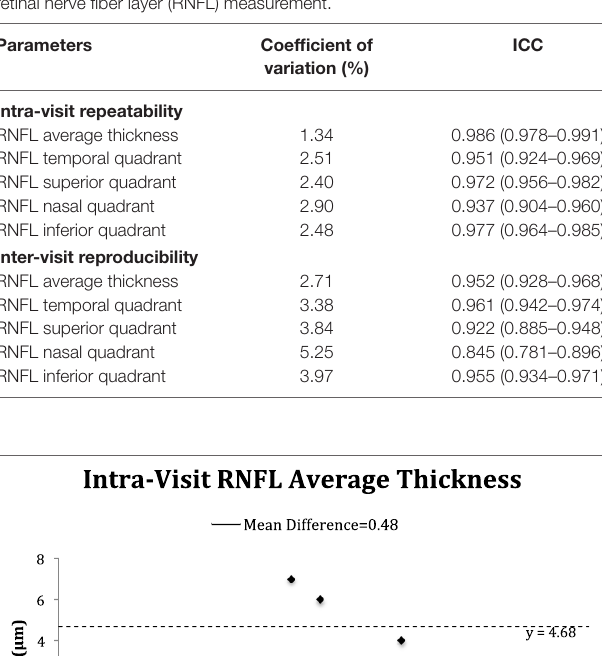
TaBle 4 | Intra-visit repeatability and inter-visit reproducibility of peripapillary retinal nerve fiber layer (RNFL) measurement.